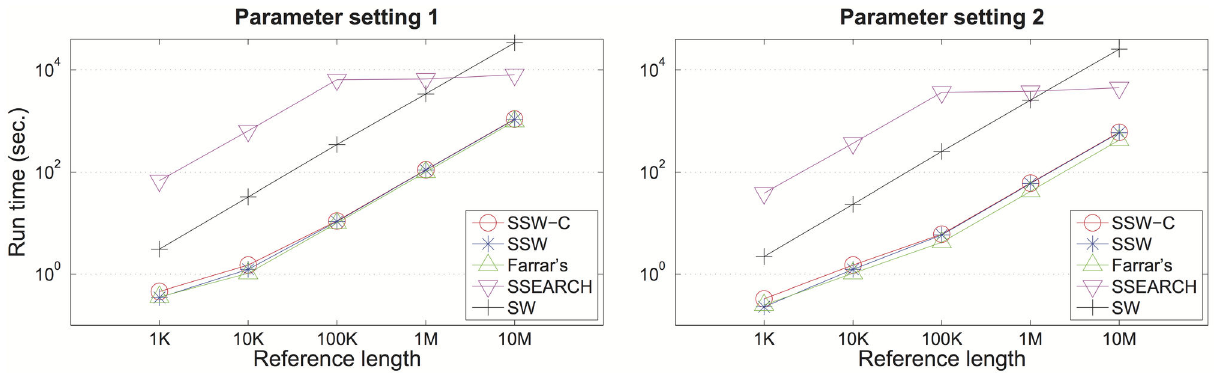
Figure 2. Running time of different SW implementations for simulated genomic read alignment. Running time of aligning 1,000 simulated Illumina reads to human reference sequences of various lengths. The log-scaled running time is shown on the y- axis for SSW without (blue) and with (red) detailed alignment, Farrar’s implementation (green), SSEARCH (pink) and an ordinary SW implementation (black). All SW implementations were tested under two sets of SW parameters: scores of match, mismatch, gap open and extension are 2, -1, -2, and -1 respectively (left), and scores of match, mismatch, gap open and extension are 1, -3, -5, and -2 respectively (right). doi: 10.1371/journal.pone.0082138.g002 alignments are shown in Table S2 in File S1. Our SSW algorithm and Farrar’s accelerated version are equally fast for the whole reference length spectrum.